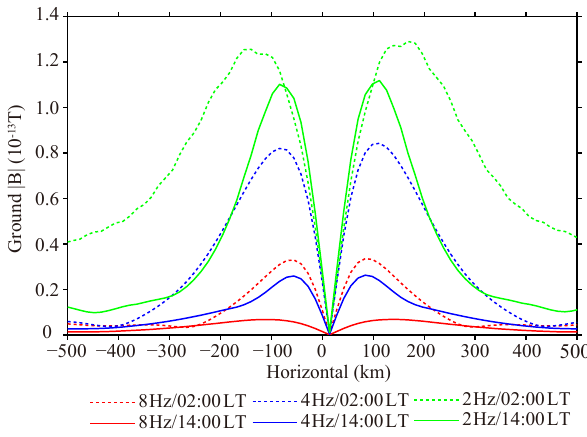
Figure 10. The ground magnitude of magnetic field of the artifi- cially generated ULF waves at the modulation of 2.0, 4.0 and 8.0Hz in the daytime and nighttime